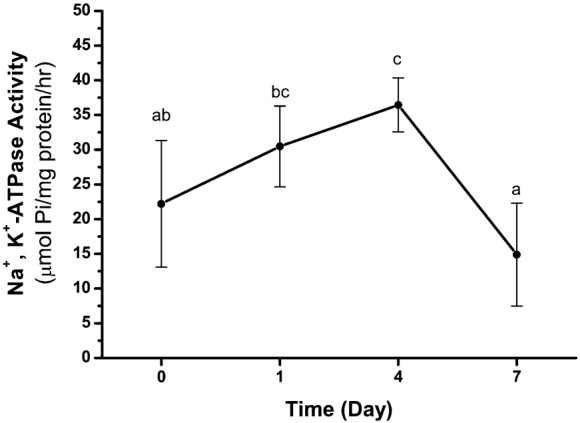
The Na+, K+-ATPase (NKA) activity in the antennal gland of Ocypode stimpsoni in 0, 1, 4 and 7 days after crabs were transferred to 5‰ seawater.Compared to the control group (0 day), the NKA activity increased and reached a significant level at the 4th day followed by a return to the normal level at the 7th day. These results are analyzed by one-way ANOVA (p<0.05) and grouping by Duncan's multiple range test. Different letters indicate significant differences (p<0.05).